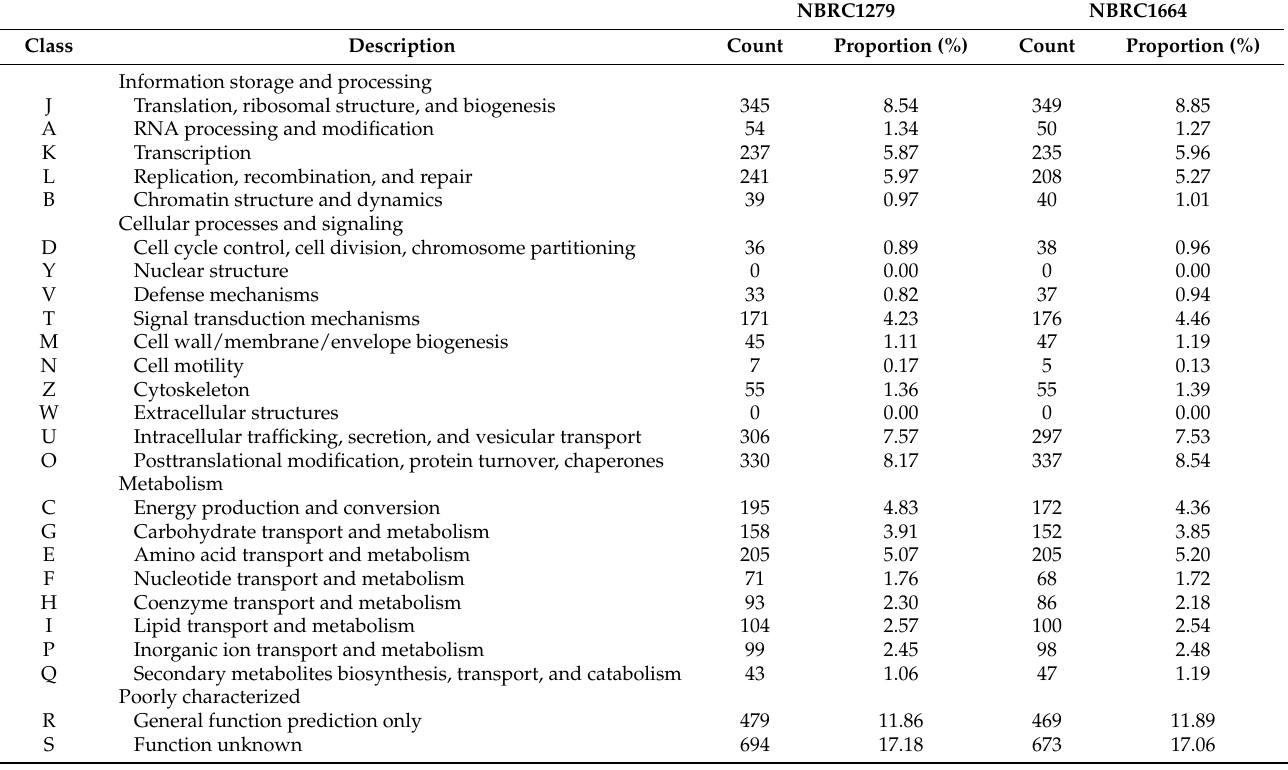
Table 4. eggNOG categories of protein coding sequences in P. kudriavzevii NBRC1279 and